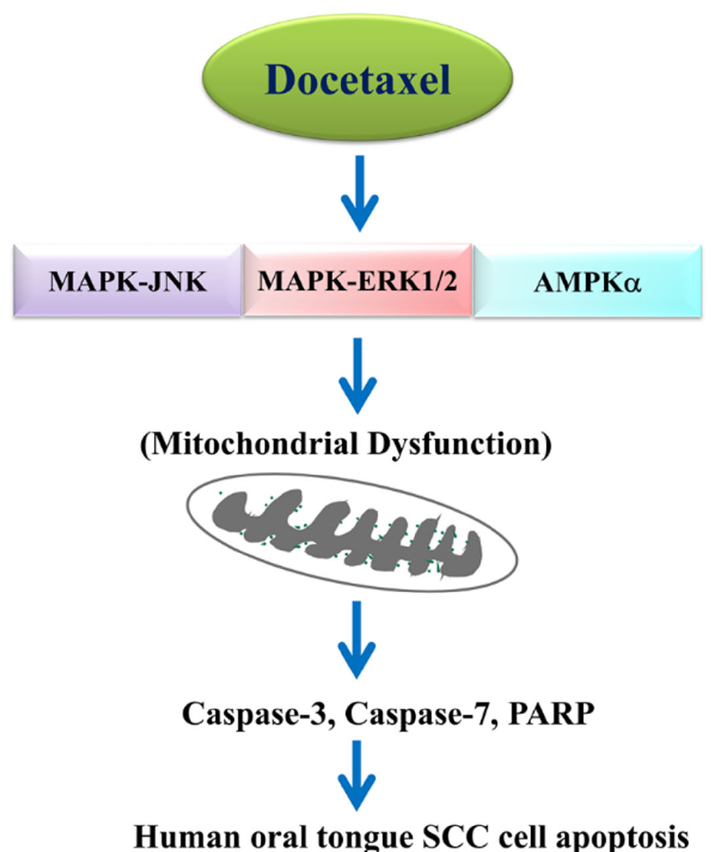
Figure 6. Schematic diagram of the signaling pathways involved in docetaxel-mediated molecular mechanism in oral tongue squamous cell carcinoma cell apoptosis.